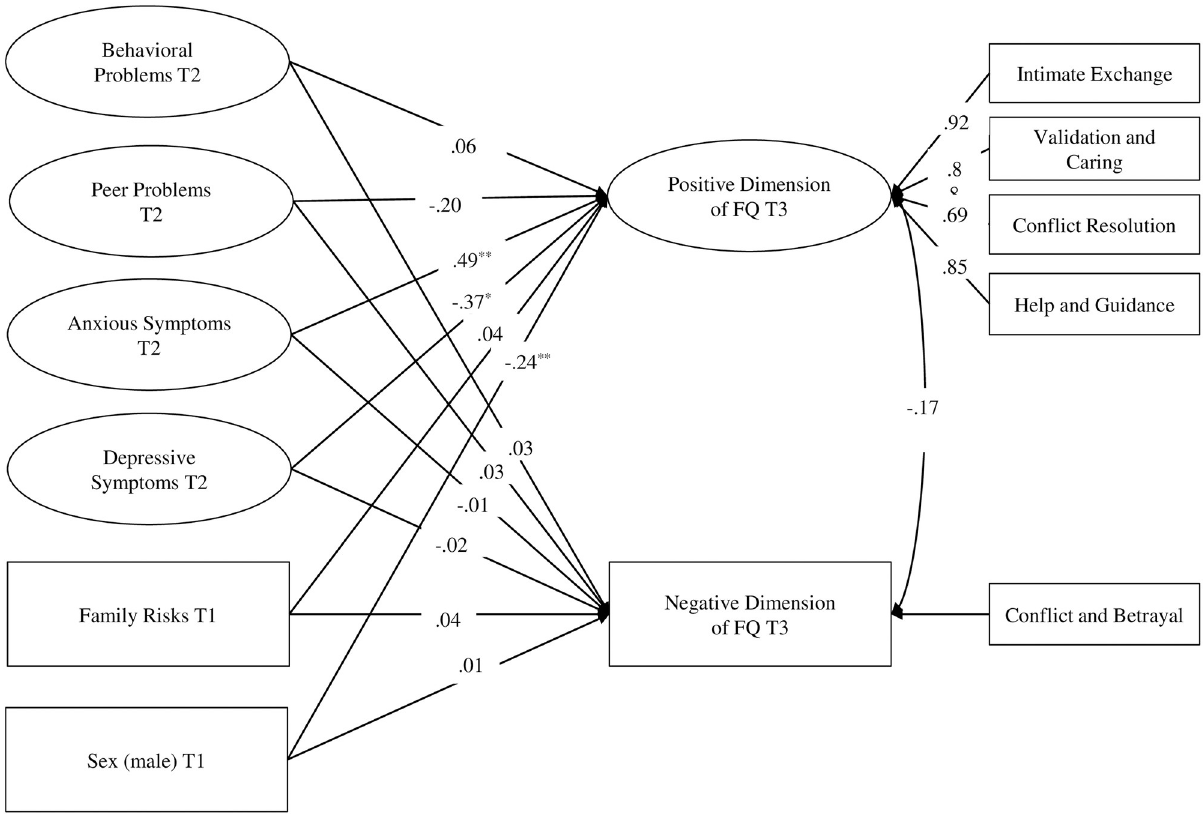
Fig 1. Standardized results from the model. T1-T2-T3 = Data measurement occasions. Model fit ( χ 2 [110] = 136.60; CFI = .97; RMSEA = .03; SRMR = .05). � p < .05; �� p < .01.